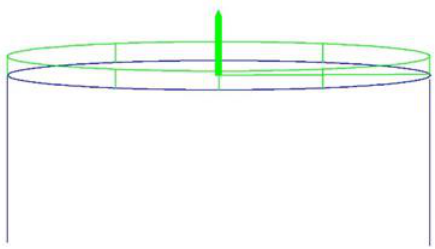
Figure 4. Model of lightning protection zone of the prilling tower with RSM.